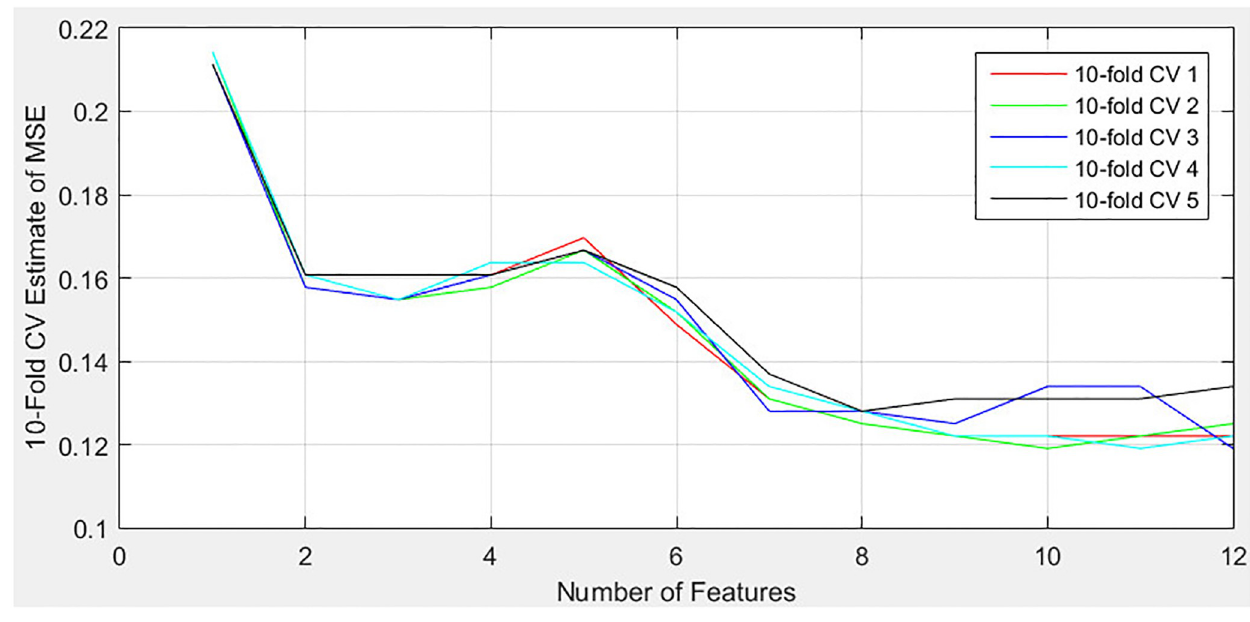
Fig 2. Estimates of MSE of different number of features.